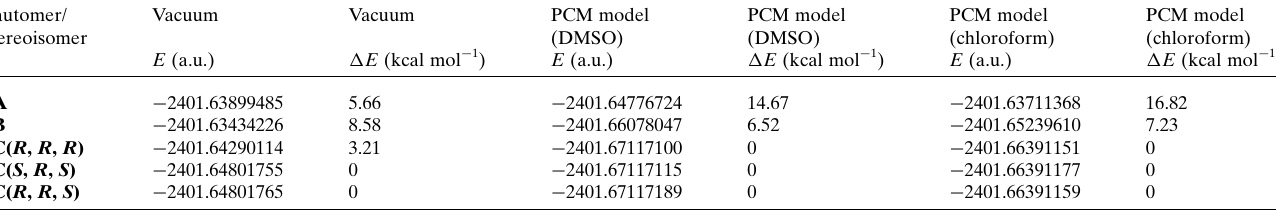
Table 1 Relative energies (kcal mol (cid:4) 1 ) of tautomeric and stereoisomeric forms, calculated by the M06–2X/cc-pVTZ method. Tautomer/ Vacuum stereoisomer